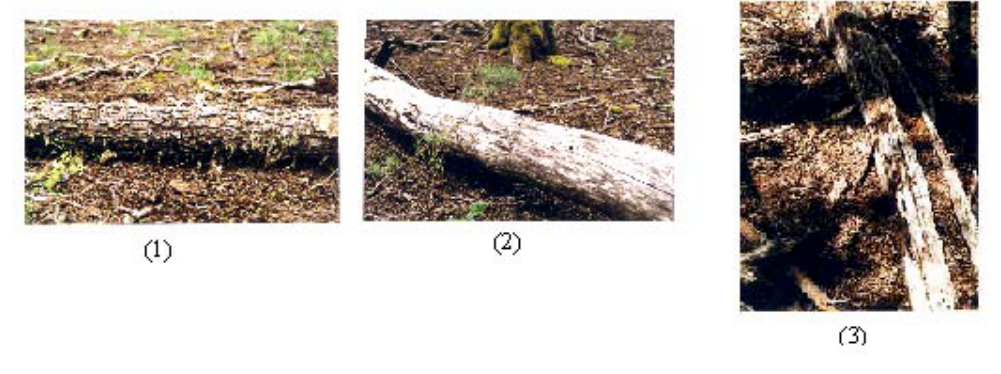
FIGURE 4 . Stages of decomposition of dead wood.